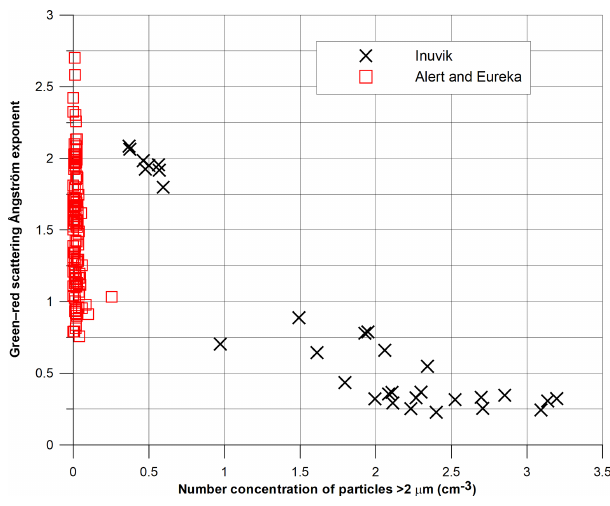
Figure 3. Light scattering Ångström exponent between green and red wavelengths plotted against the number concentrations of coarse particles ( > 2µm diameter). Data are separated between those col- lected during flights from Alert and Eureka (red boxes) and from Inuvik (black